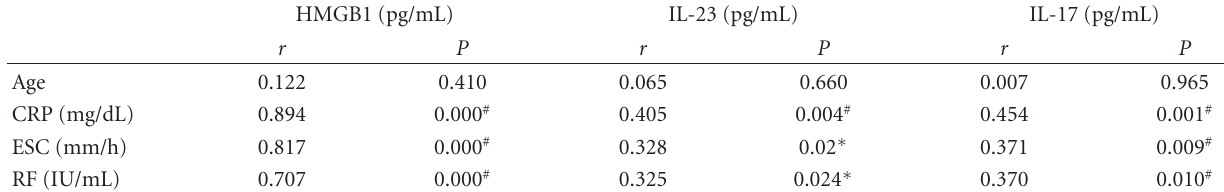
Table 3: Correlations of HMGB1, IL-23, IL-17, and clinical index in the serum of active RA patients.